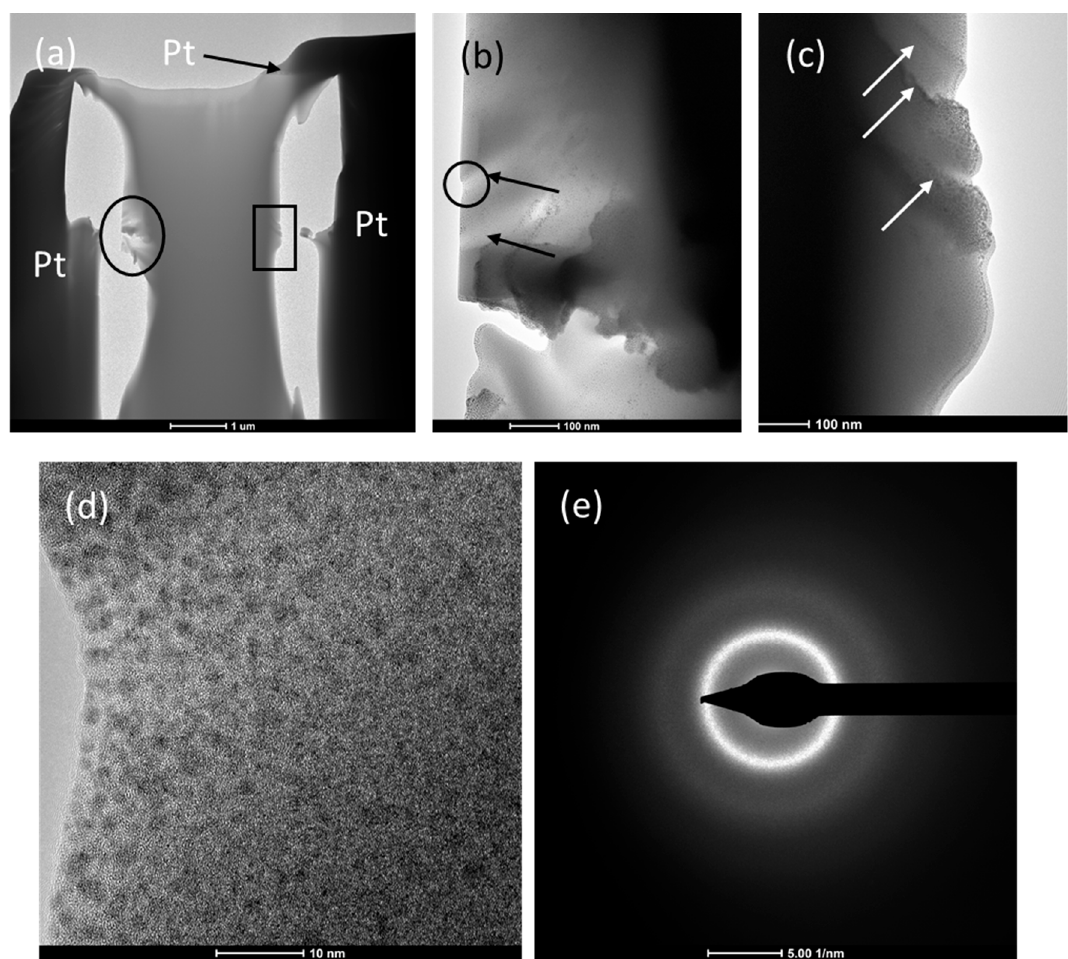
Figure 8. Typical TEM micrographs of a deformed micropillar of Ø 3 µm under 10 − 3 s − 1 strain rate: ( a ) BF-TEM image, ( b ) and ( c ) high magnification TEM of the area are indicated in Figure 8a and ( d ) HRTEM image on region indicated in Figure 8b and ( e ) corresponding SAED pattern. Pt denotes platinum that was deposited to protect the material surface in the course of TEM sample preparation in FIB-SEM.